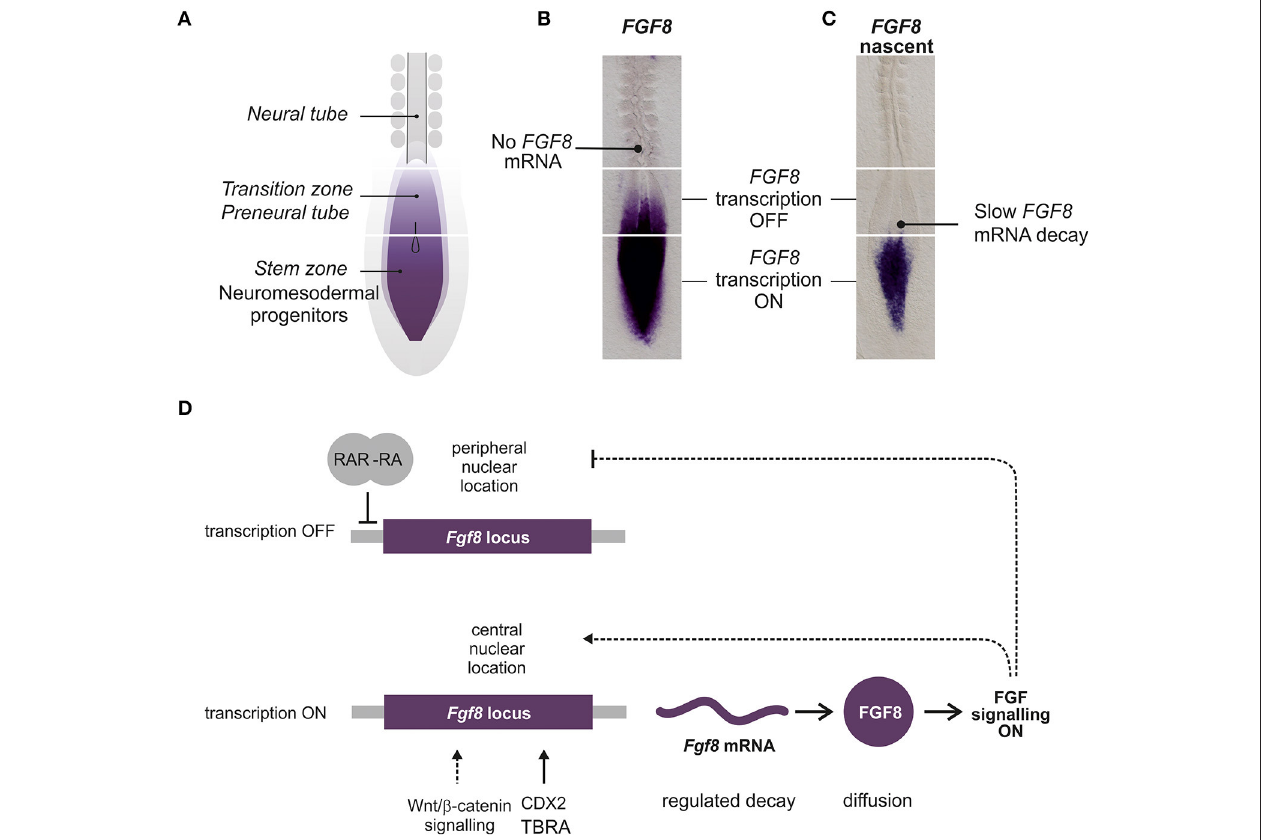
FIGURE 3 | Regulation of caudal FGF8/Fgf8 expression during spinal cord extension. (A) Diagram representing the caudal part of a chick embryo where the different regions related to FGF8 expression are labeled. (B) Chick embryo showing FGF8 mRNA detected by in situ hybridization with a full length FGF8 probe. (C) Embryo showing the nascent FGF8 pre-mRNA detected by in situ hybridization with an intronic FGF8 probe. (D) Diagram representing the main factors contributing to the expression of Fgf8 in the caudal NMP. Lines represent possible direct interactions of transcription factors and dashed lines indirect